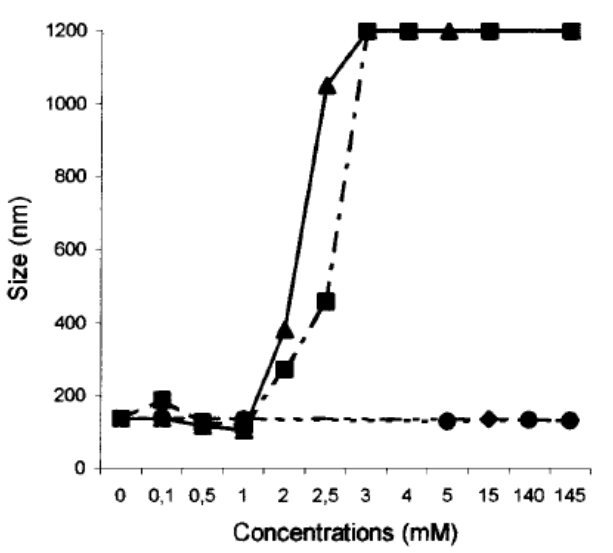
Figure 21. Variation of the diameter of solid lipid nanoparticles formed by 15 in the presence of varying concentrations of Na + ( ♦ ); K + ( ● ); Mg 2+ ( ■ ); and Ca 2+ ( ▲ )